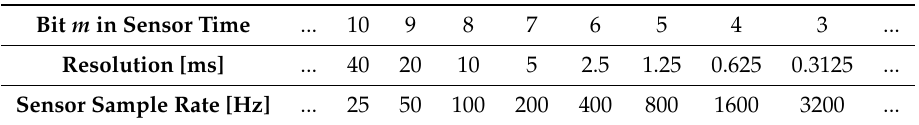
Table 1. Sensor timer aligned data